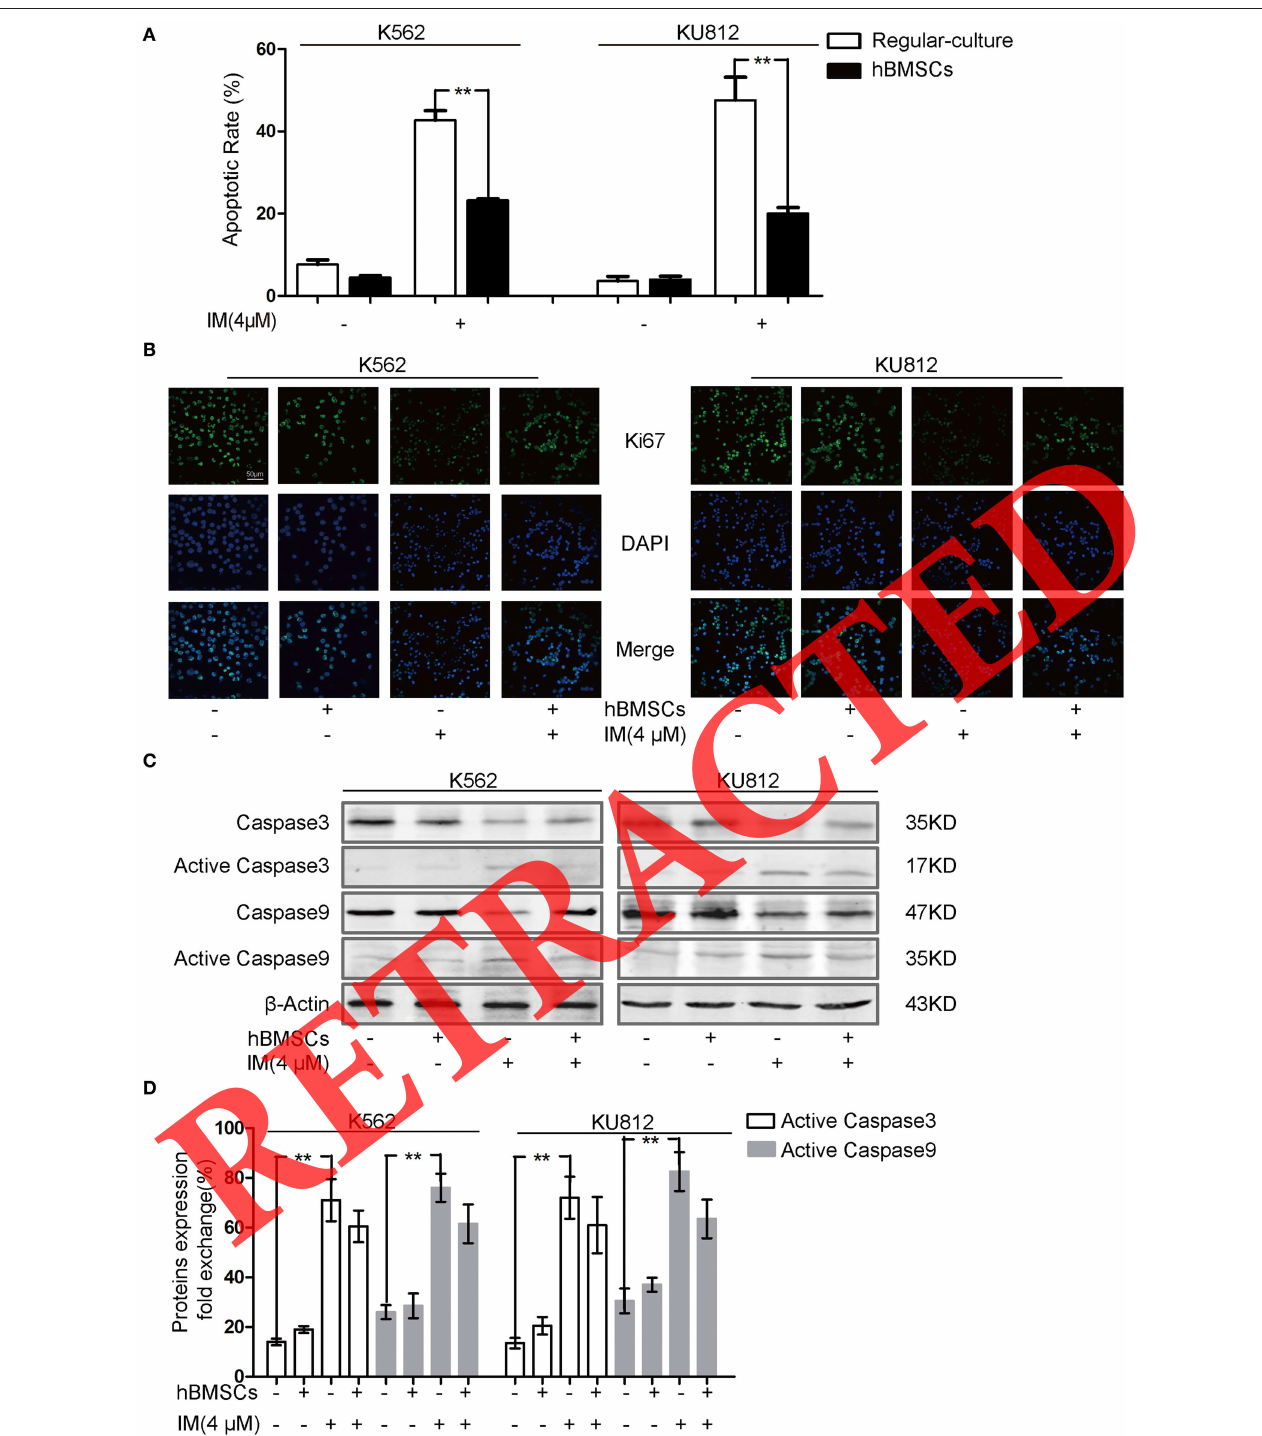
FIGURE 1 | BM microenvironment protected CML cells from IM attack. K562 and KU812 cells were cultured with or without hBMSCs and with or without 4 µ M IM for 48h. Cell proliferation was determined by Annexin V-PI double-staining assay and Ki67 cell proliferation detection. (A) Apoptosis rate of K562 and KU812 after treatment by IM with or without hBMSCs. (B) Ki67 cell proliferation detection of K562 cells after treatment. (C) The expression of cleaved-caspase3 and 9 was determined using western blot analysis. (D) Analysis of proteins expression. Data (A) and (D) were shown as Means ± SD for three independent experiments ( * p < 0.05 and ** p <